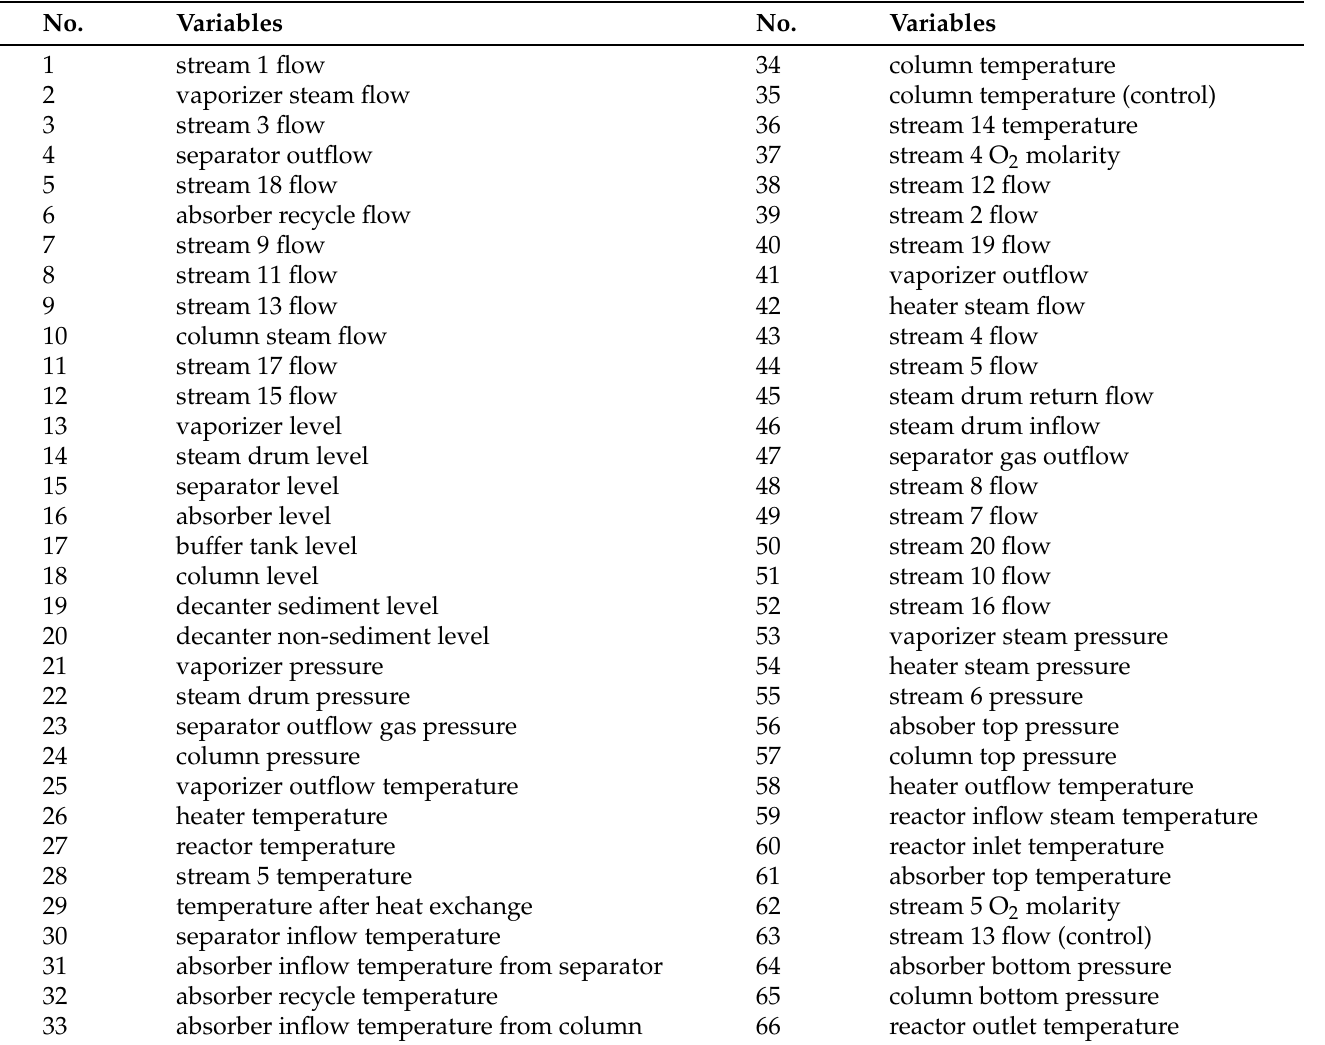
Table 1. Variables in VAM process.